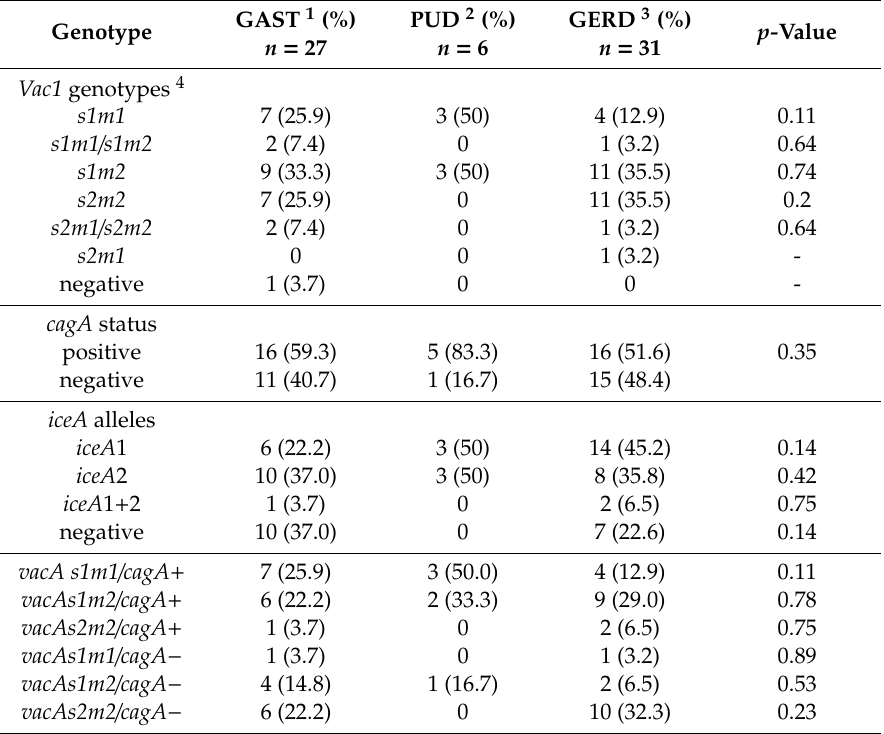
Table 3. Genotypes of H. pylori strains and clinical